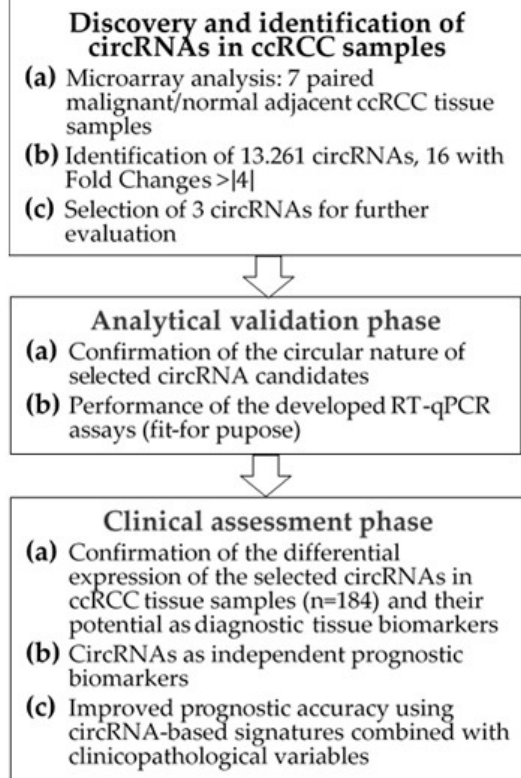
Figure 1. Flowchart of the study. Abbreviations: circRNA, circular RNA; ccRCC, clear cell renal cell carcinoma; RT-qPCR, reverse-transcription quantitative real-time polymerase chain reaction.